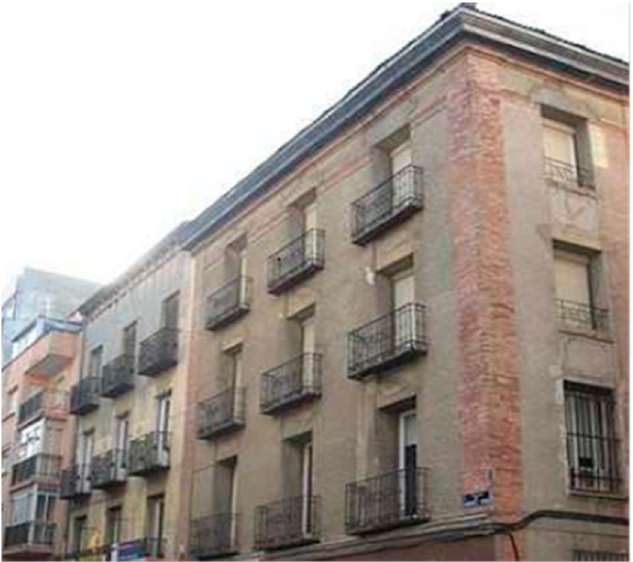
Figure 4. Panoramic view of the historical building.